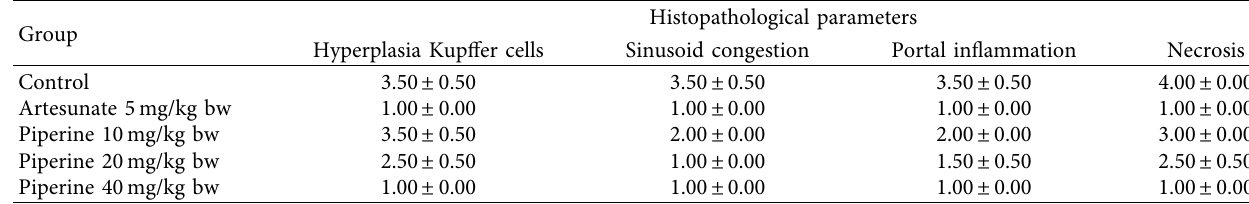
Table 2: Semiquantitative analysis of liver histopathology in the curative test.